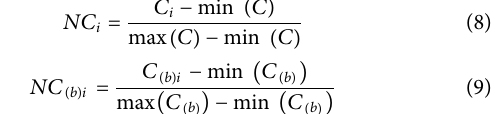
network nodes. Platinum mines (M) and mines ’ countries (CM), platinum mines (M) and af fi liated platinum production companies (F), platinum mines (M) and shareholder of platinum production companies (S), platinum production companies (F) and company ’ s countries (CF), platinum production companies (F) and the shareholders of the platinum production companies (S), the shareholder of the platinum production companies (S) and the shareholder ’ s countries (CS) are established as edges (Figure 2), with the platinum production as the weight of the edges. The size of the node re fl ects the production of a supplier, that is, the bigger node represents the greater production of the corresponding supplier. The width of the edge represents the scale of mine production, that is, the thicker edge indicates the greater production between the two suppliers.